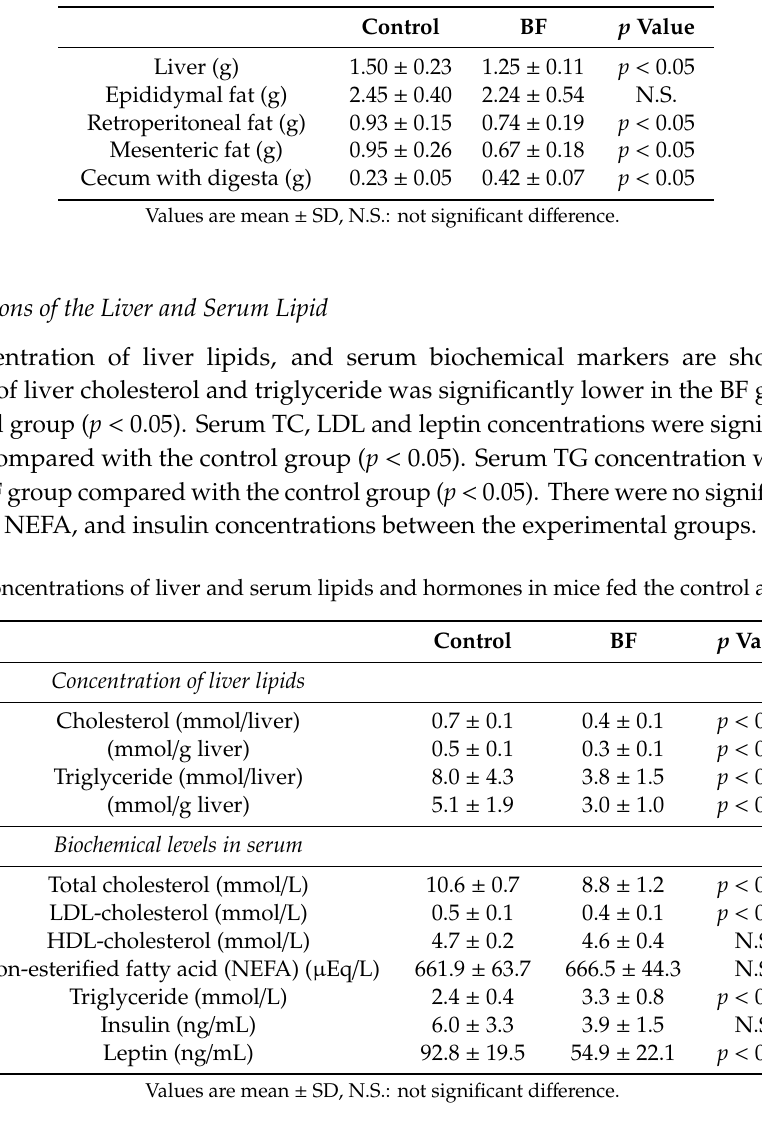
Table 4. Organ weights in mice fed the control BF and diets.